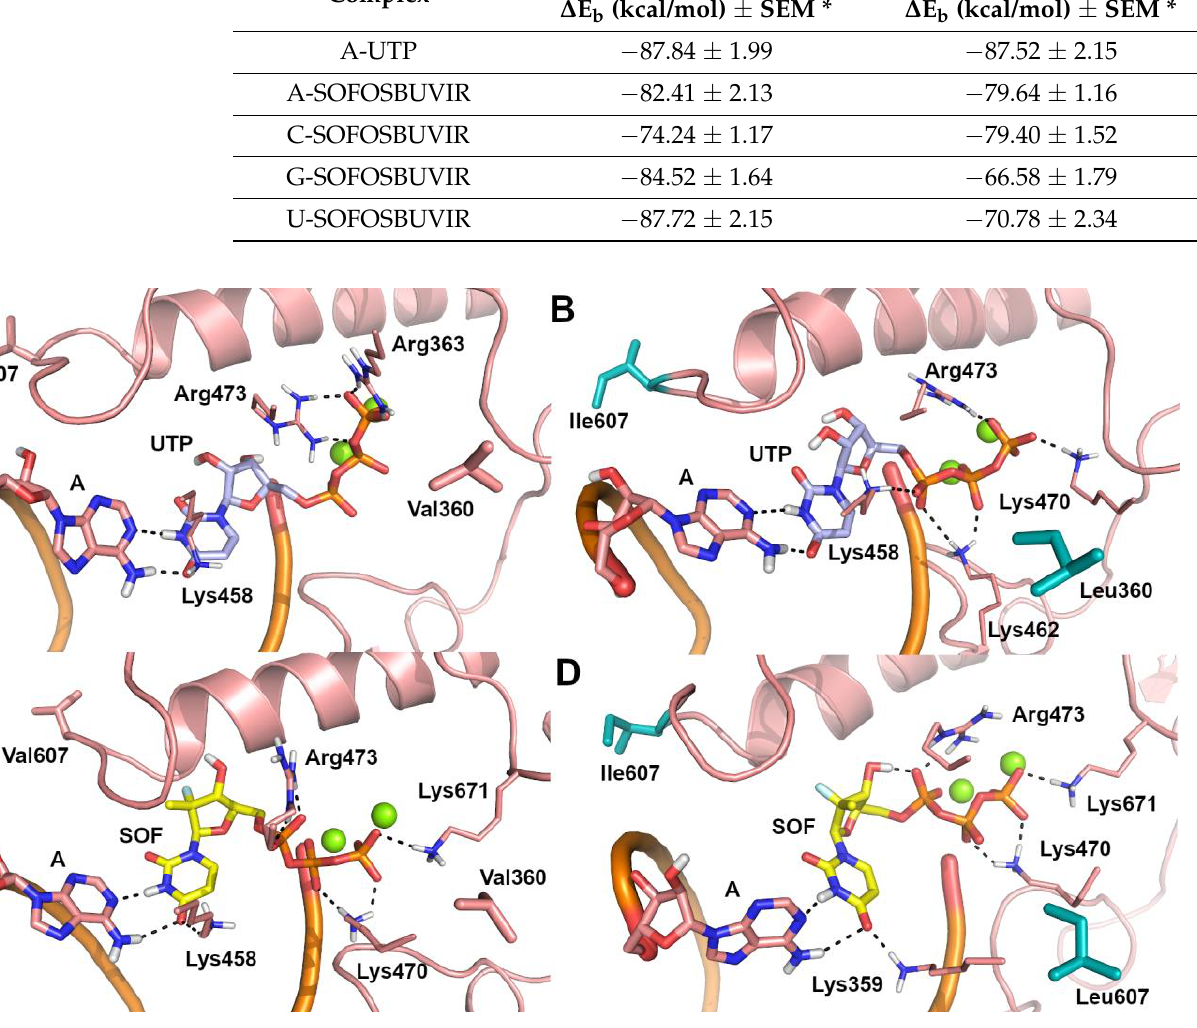
Figure 1. Predicted binding poses of UTP (light blue sticks) and sofosbuvir (SOF) (yellow sticks) within the catalytic site of ZIKV RNA dependent RNA polymerase (RdRp), in the representative structure extrapolated from molecular dynamics (MD) trajectories. ( A ) A-UTP-WT ZIKV RdRp system. ( B ) A-UTP-V360L/V607I mutant ZIKV RdRp system. ( C ) A-SOF-WT ZIKV RdRp system. ( D ) A-SOF-V360L/V607I mutant ZIKV RdRp system. Polar contacts are highlighted by black dashed lines. Residues involved in polar and non polar interactions with UTP and sofosbuvir are shown as sticks and are labelled. The opposite A from the RNA template is shown as sticks. Mg 2+ ions are shown as green spheres. Mutated residues are highlighted by cyan sticks.